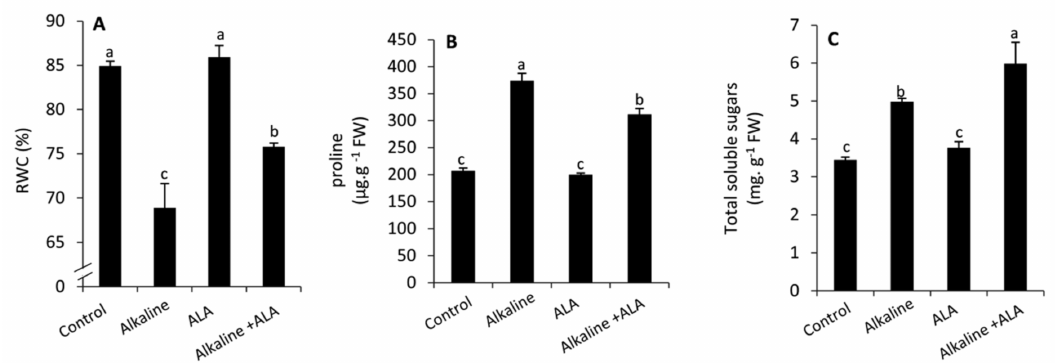
Figure 2. Effect of exogenous α -lipoic acid (ALA; 20 µ M) on RWC ( A ), proline ( B ), total soluble sugars ( C ) of wheat seedlings grown under sodic alkaline stress. RWC, leaf relative water